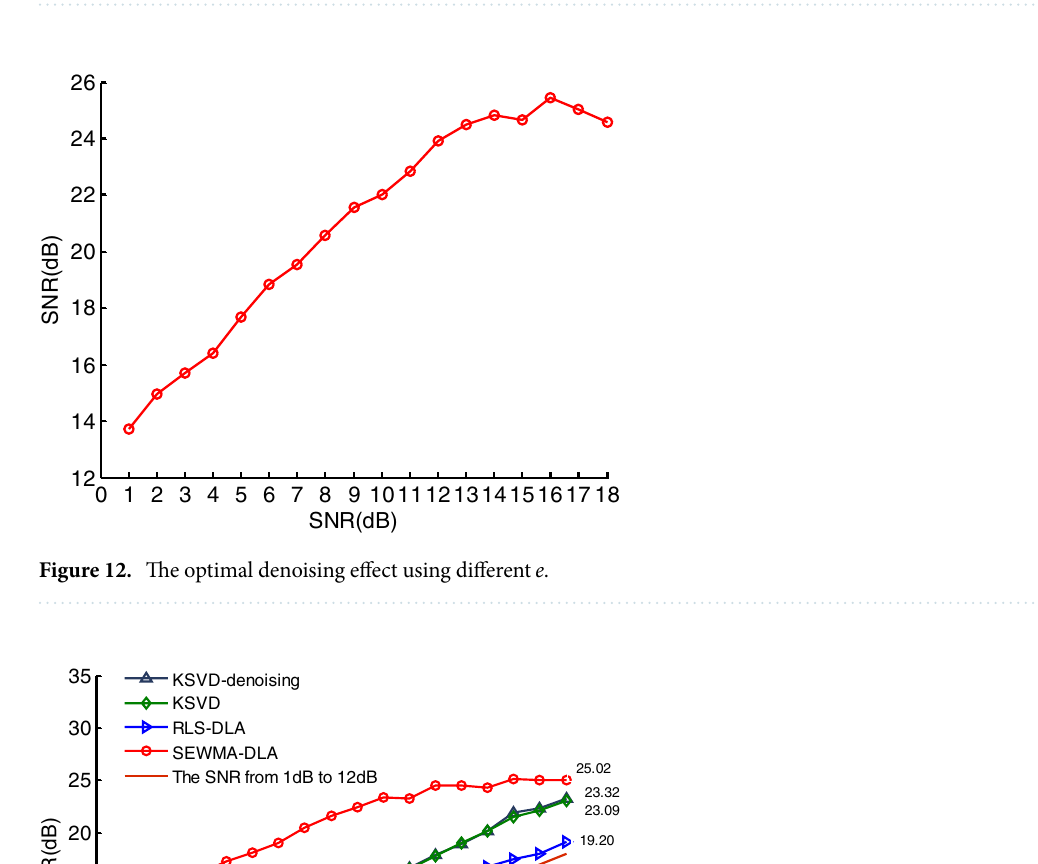
Figure 11. The denoising effects of PPS using different e .